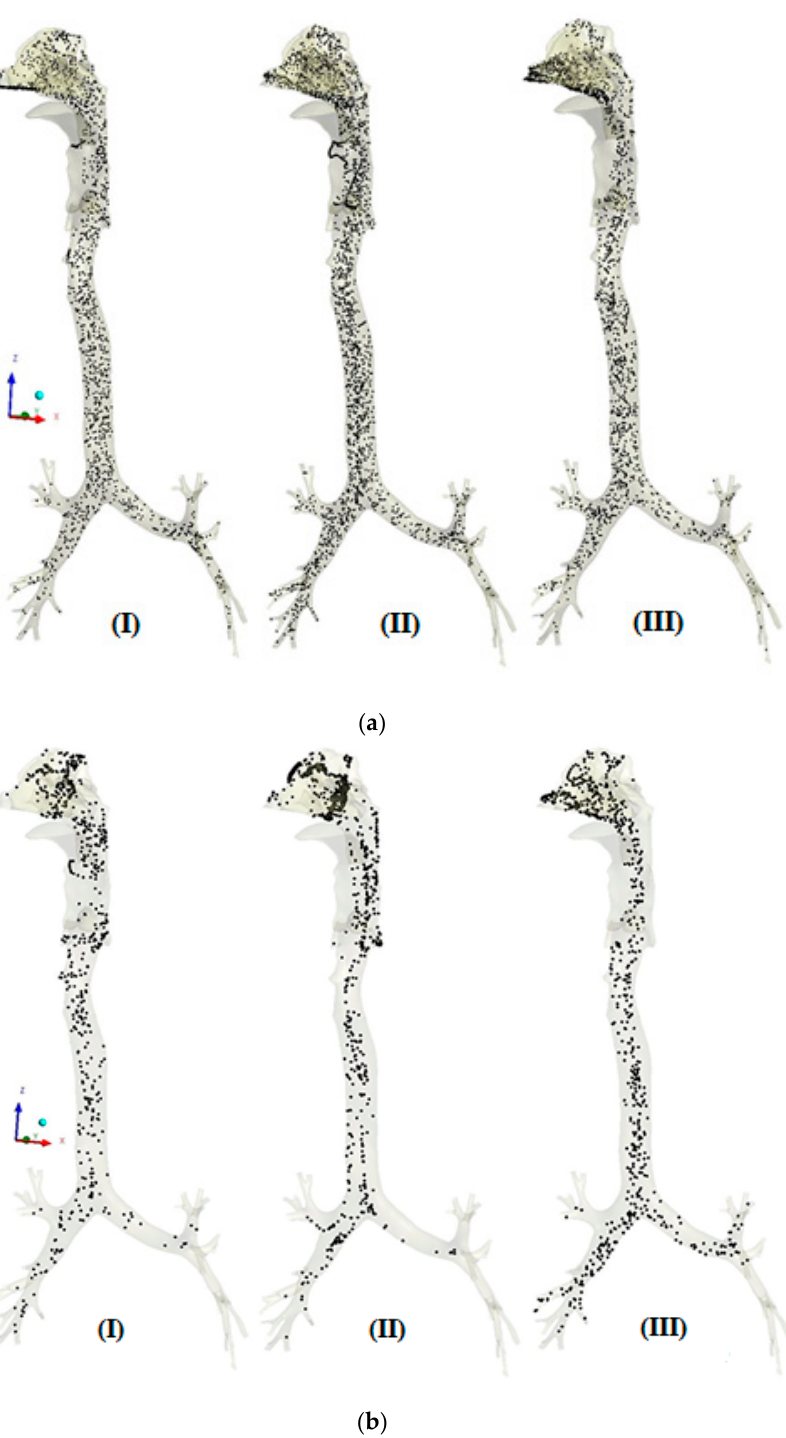
Figure 4. ( a ) Transport pattern of PM 2.5 during normal inspiration. ( b ) Transport pattern of PM 10 during normal inspiration.